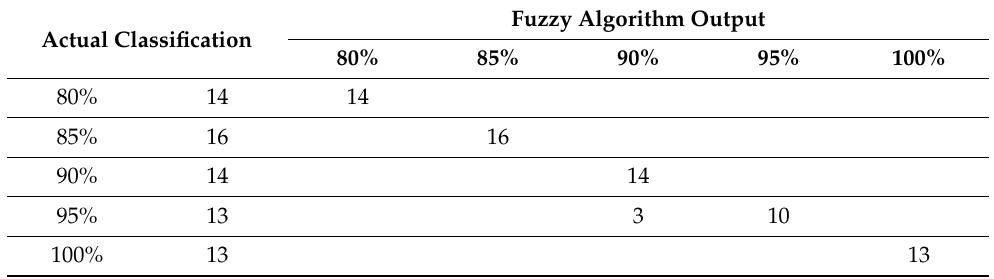
Table 10. The matrix results of testing using fuzzy